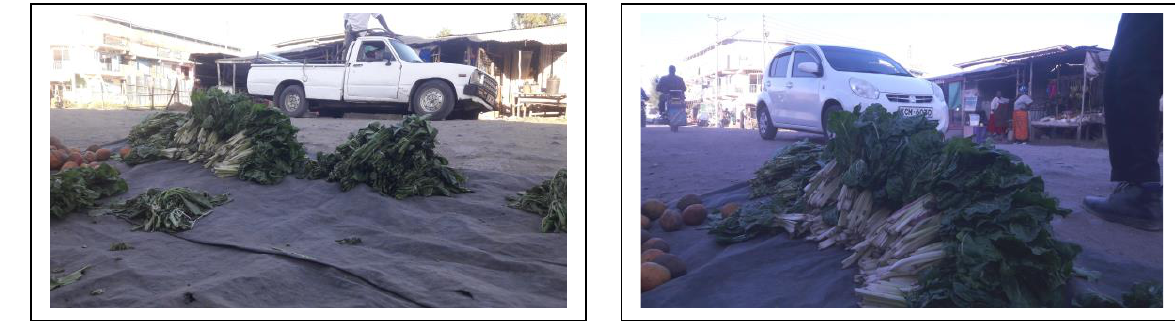
Figure 2: Vegetables were displayed along the dusty roads at Malaa shopping Centre in About 40% of the households' income was used in purchasing foodstuffs exposing them to food deprivation risks. This is consistent with findings in South Africa where food accounts for largest household expenditure at 39% in poor households at Cape Town (Crush & Frayne, 2010). At any given time of the year, the lowest cost of a handful of kales (0.5kg), enough for a family of three, was US$0.2 compared with US$0.05 in rural areas. To feed a family of 4-5, vegetable worth at least US$0.3 was required. During dry seasons, the cost rose to US$0.7 for a family of 4-5. A kilogram of indigenous vegetables retailed at US$1 during dry seasons. Sometimes, some foodstuffs, particularly indigenous vegetables, were unavailable in the markets. The prices varied from season to season but remained relatively high throughout the year. Most (96%) of the vegetable and cereal vendors were concentrated in shopping centres. The far-off households would travel up to 5km to access these markets hence deterred from frequent consumption of a variety of vegetables and fruits. Overall, such seasonal unavailability and inaccessibility of food encouraged the establishment of home gardens. On average, it took 1.5 years for the newly settled households to embrace home gardening. However, about 32% of the households were not practicing home gardening citing problems such as inadequate space, water shortage, lack of garden caretaker and that gardening was time-consuming with low return on investment.